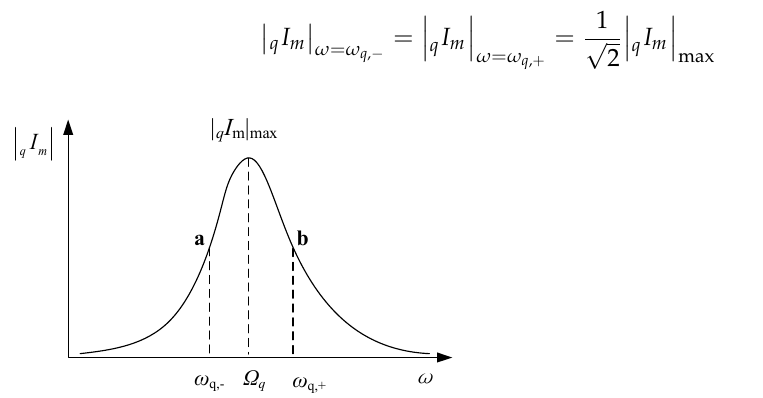
I versus the operating angular frequency ω . Figure 2. q | I m | versus the operating angular frequency ω Figure 2. mq